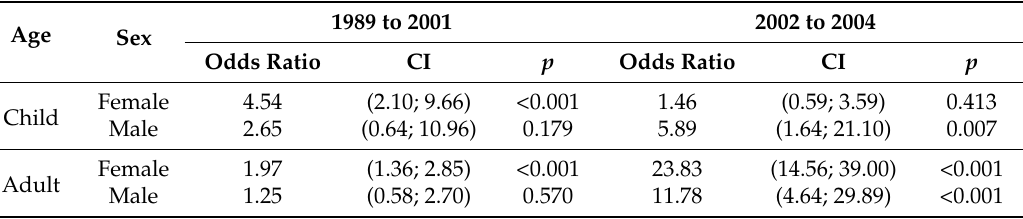
Table 4. Odds ratios of primary hypothyroidism and 95% confidence intervals (CI) for comparison between Region A and Region